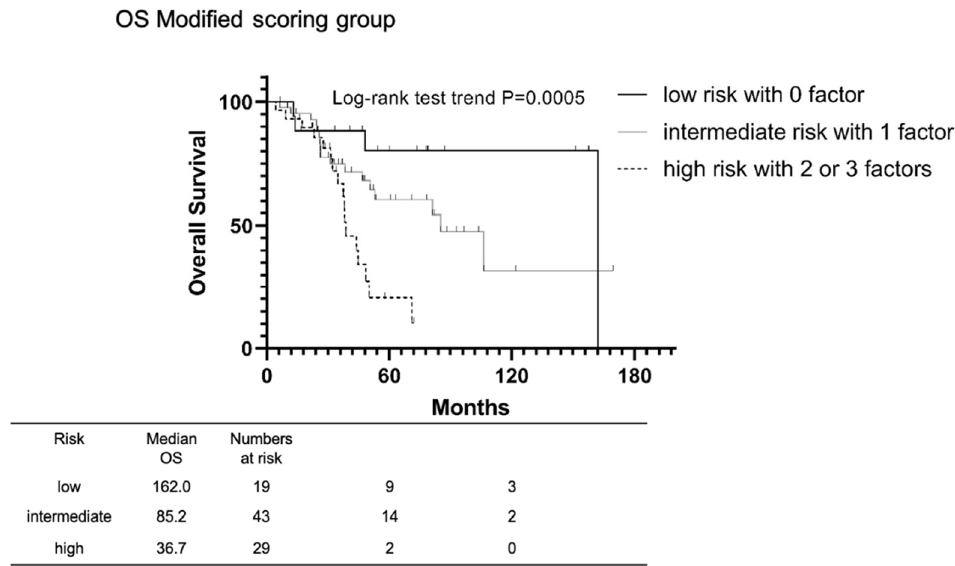
Figure 3. Kaplan-Meier estimates of cumulative OS in patients with mHNPC stratified by inclusion of GP 5, BSI ≧ 1.5, and LDH ≧ 300. Patients for whom information was available on all three identified risk factors were selected. Low risk patients had no risk factor, intermediate risk patients had one factor, and high-risk patients had two or three factors. OS tended to decrease as risk increased (Log-rank test trend, p = 0.0005). GP: Gleason pattern; BSI: bone scan index; LDH: lactate dehydrogenase.